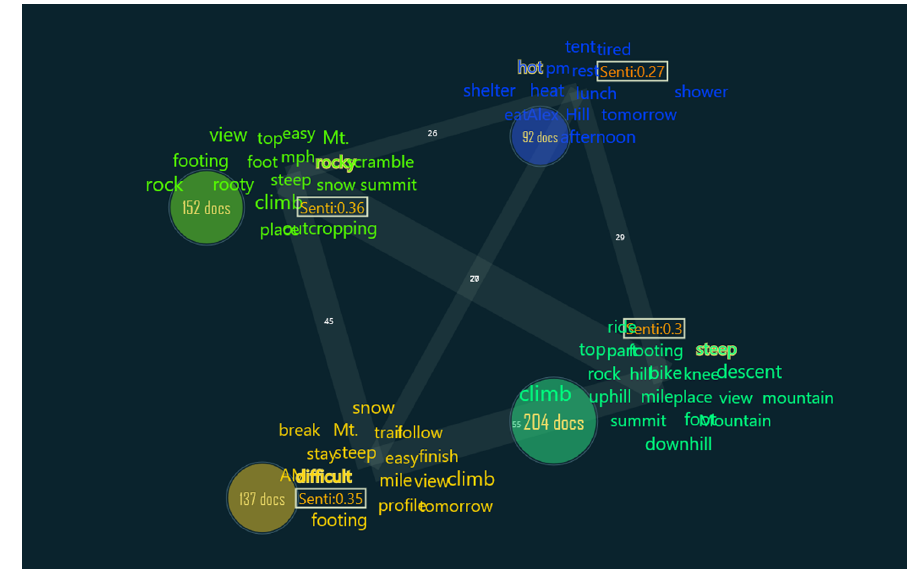
Figure 9. Four word clouds created by